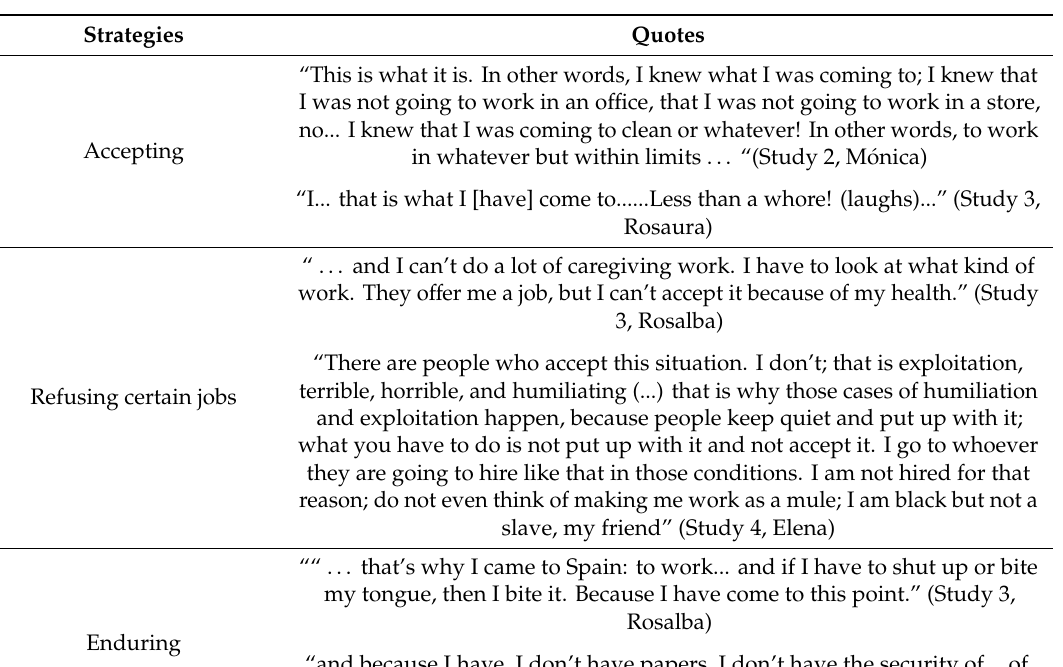
Table 3. Coping Strategies Endured by Latin American Immigrant